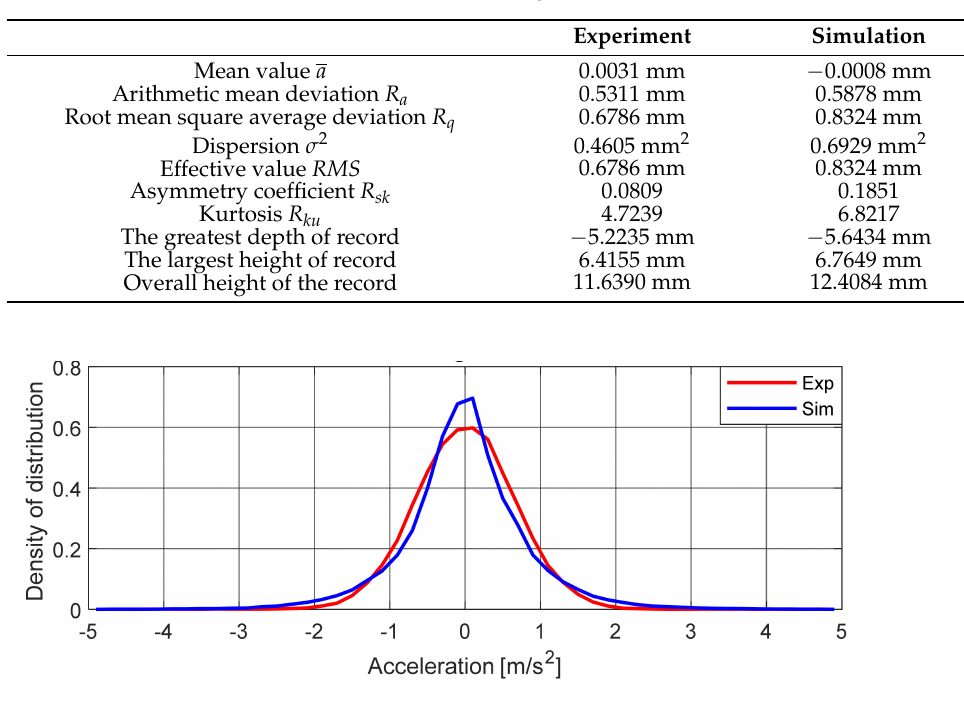
Table 3. Statistical characteristics of acceleration on right front axle.